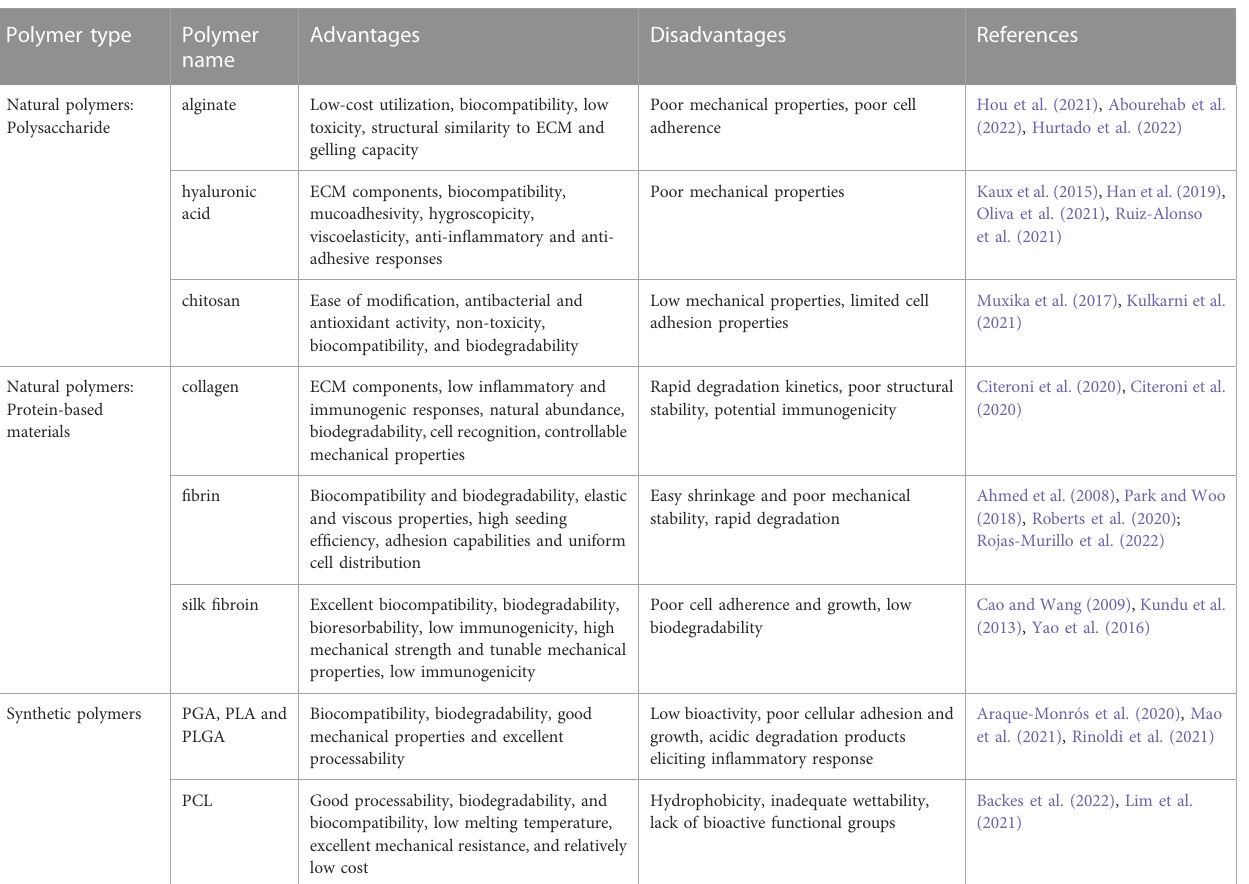
TABLE 1 Overview of some commonly used natural and synthetic polymers for tendon tissue